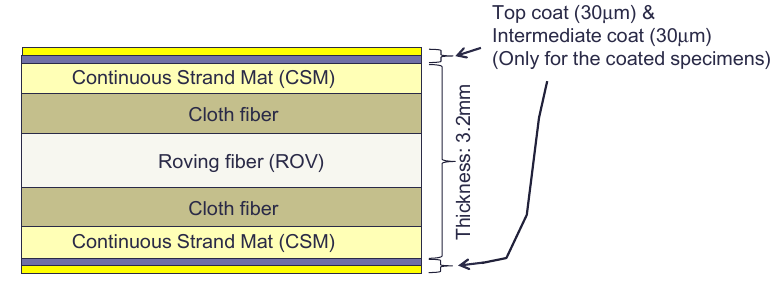
Figure 1. A schematic illustration of cross-section of the specimens. Table 1. Laminate system of the specimens.